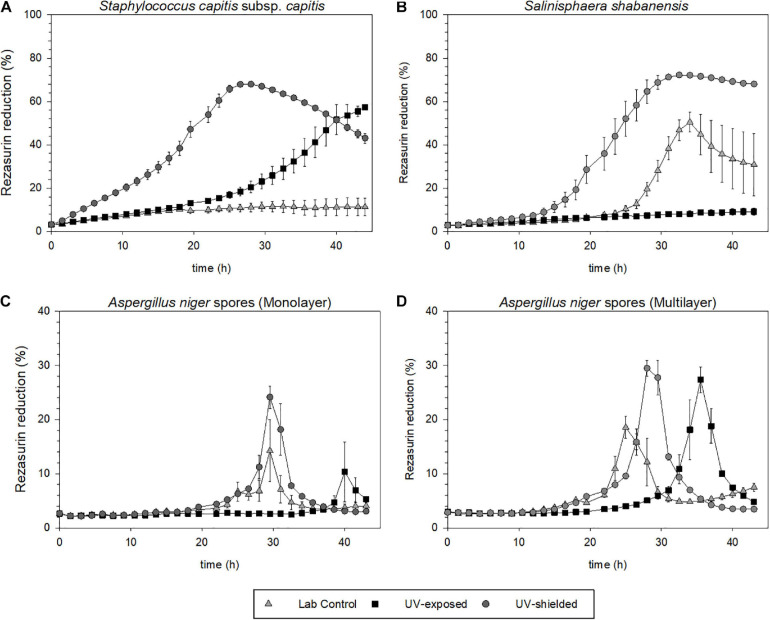
Metabolic activity upon revival, after exposure to Mars simulated conditions aboard the MARSBOx payload. Metabolic activity is depicted as percentage of reduced resazurin. (A)
S. shabanensis
(B)
S. capitis subsp. capitis. (C,D)
A. niger spores in monolayer (C) and in multilayer (D).